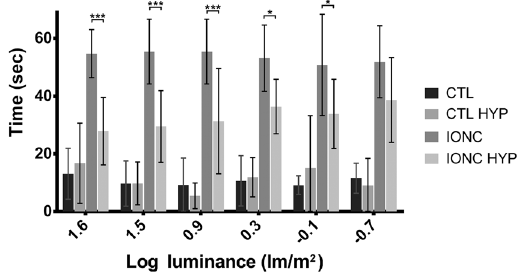
Figure 2. Time latencies needed for experimental rats to find the escape platform in the two-choice visual discrimination apparatus. The 4 experimental groups were sham operated rats (CTL), sham operated rats treated with hypothermia (CTL HYP), IONC operated rats (in both eyes), and IONC operated animals (in both eyes) treated with hypothermia (IONC HYP). Bars represent the mean ± SD of all samples (n = 10 animals per group). Asterisks represent statistically significant differences. * p < 0.05; *** p < 0.001; comparing IONC versus IONC HYP.